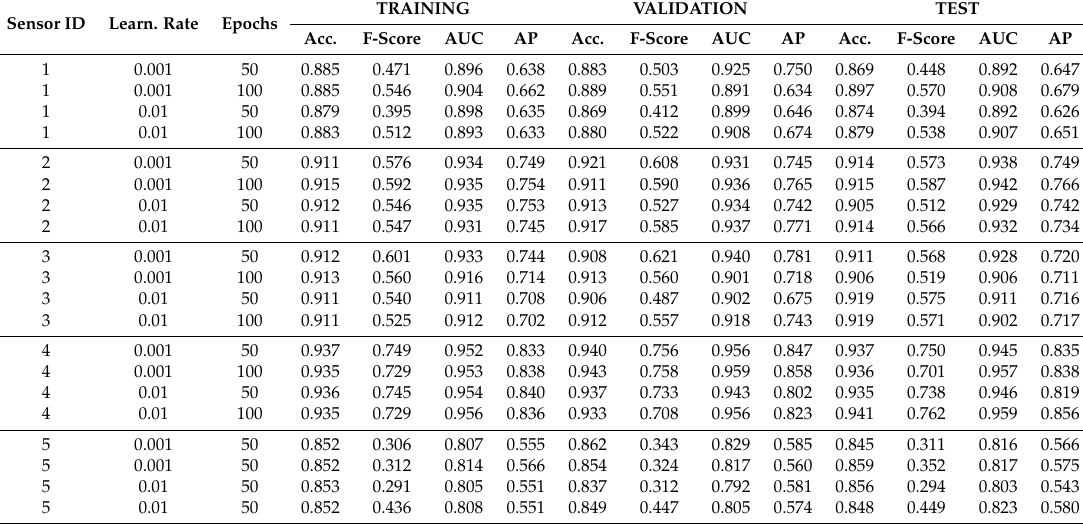
Table 7. Results of first Neural Network model for Adaptive Moment Optimization (Adam) optimizer. Sensor ID Learn. Rate Epochs